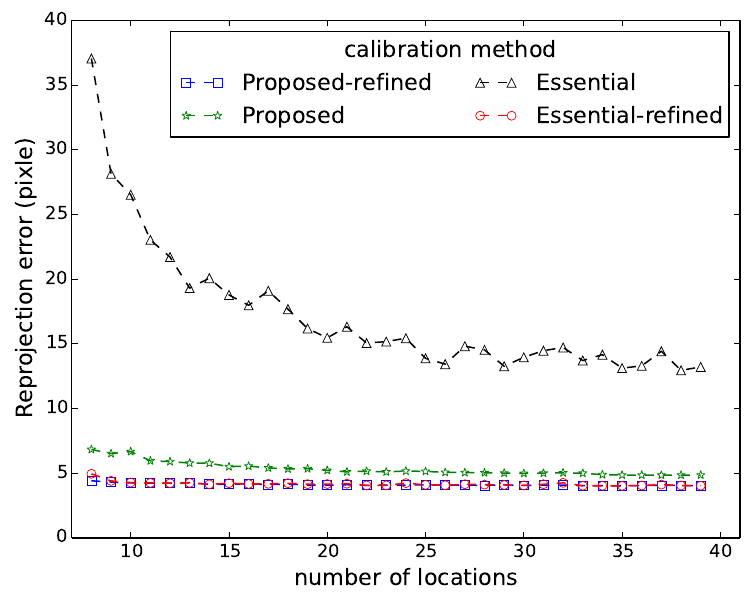
Figure 8. Reprojection error comparison between our method (proposed) and the method of Hödlmoser et al. [17] (essential) using different numbers of locations. Each location yields two calibration samples (head and feet).